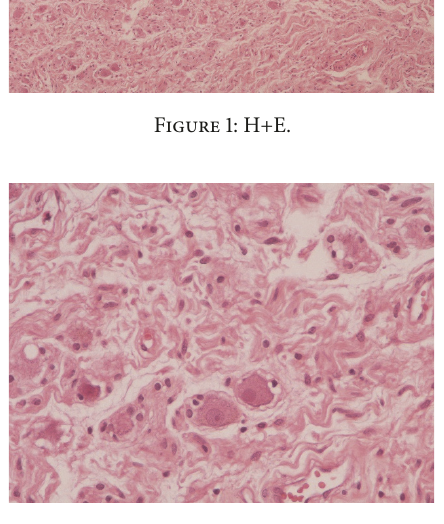
Figure 2: Ganglion cells.